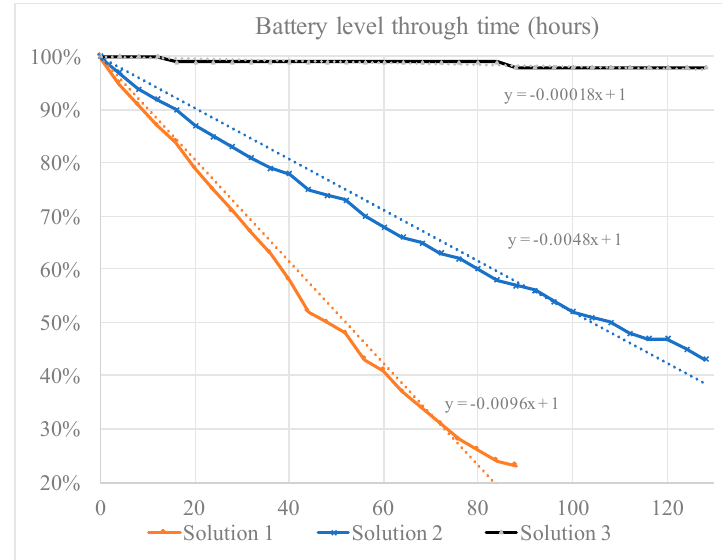
Figure 11. Experimental battery test and capacity dropping for the three different solutions.